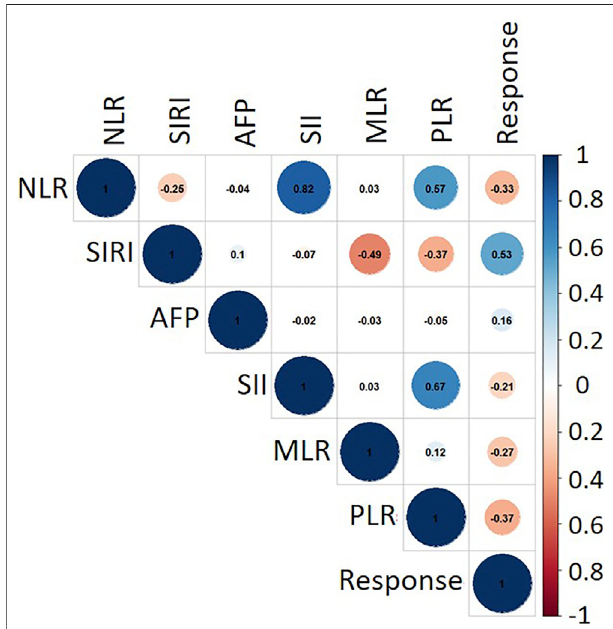
FIGURE 6 | Correlation matrix between clinical evaluation indexes. The closer the absolute value of correlation coef fi cient was to 1, the stronger the correlationbetweenvariableswas.Theclosertheabsolutevalueofcorrelation coef fi cient was to 0, the weaker the correlation between variables was. The blue circle denotes a positive correlation, while red indicates a negative